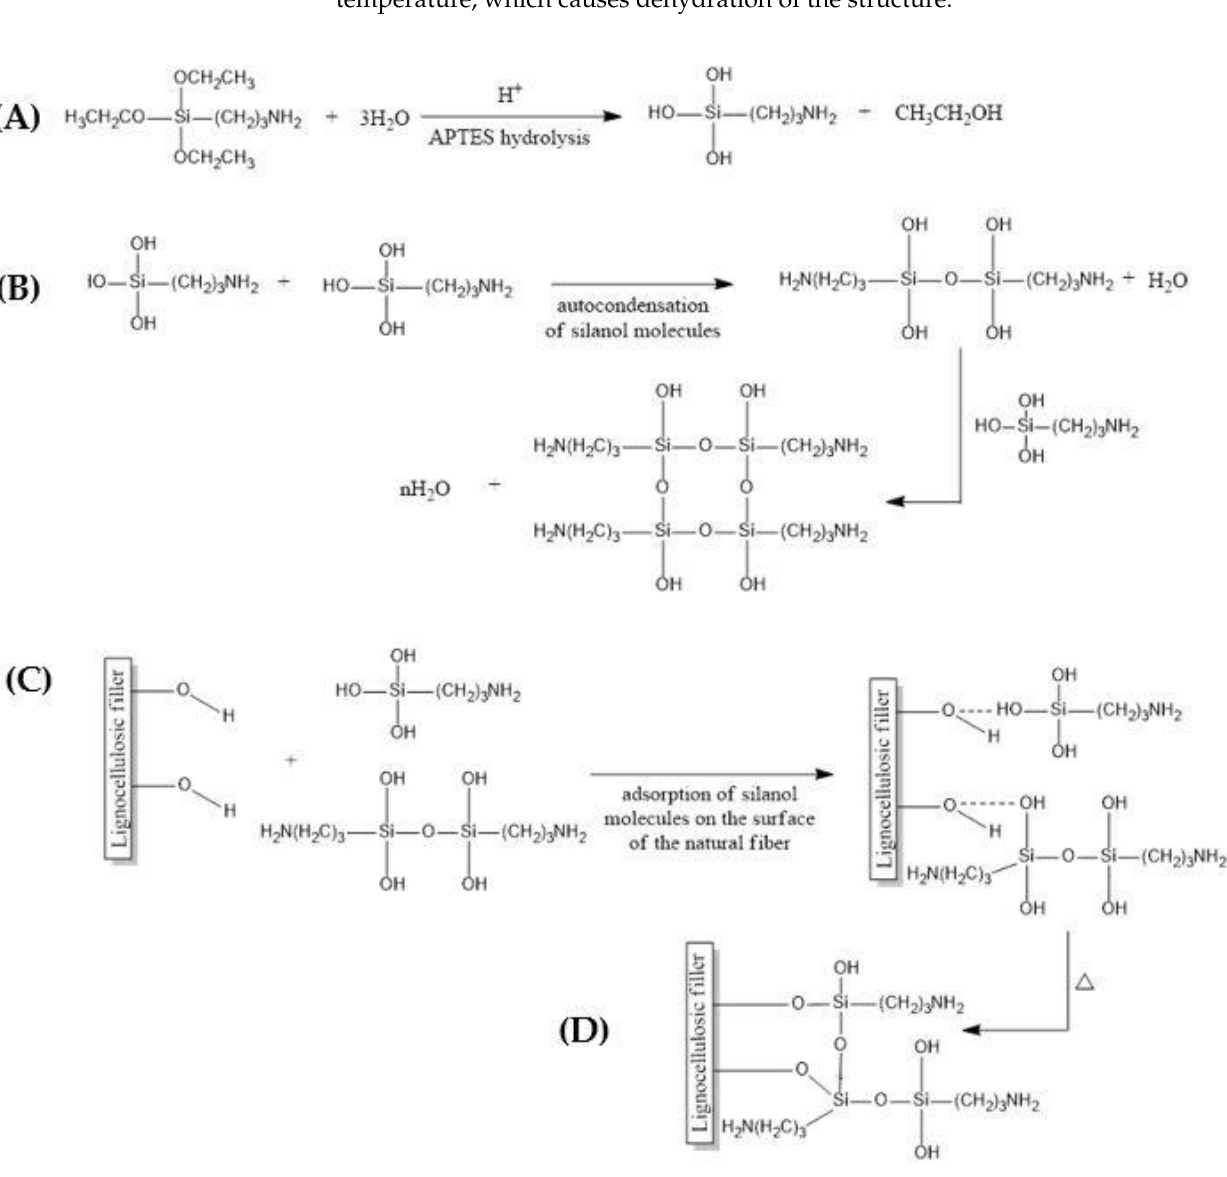
Figure 3. Silanization of lignocellulosic waste using 3-aminopropyltriethoxysilane. ( A ) the hydrolysis of silane molecules; ( B ) self-condensation of silanol molecules; ( C ) the adsorption of silanol molecules on the surface of the lignocellulosic filler; ( D ) the grafting of silanol molecules. The modified products via the silanization process, and also unmodified fillers in a form of oak and peanut shell flour were analyzed both using spectroscopy measurements and capturing SEM microphotographs. The spectrum (Figure 4, Table 1) presents the changes in the chemical structure, which were revealed after the performed modification of the bio-based fillers.